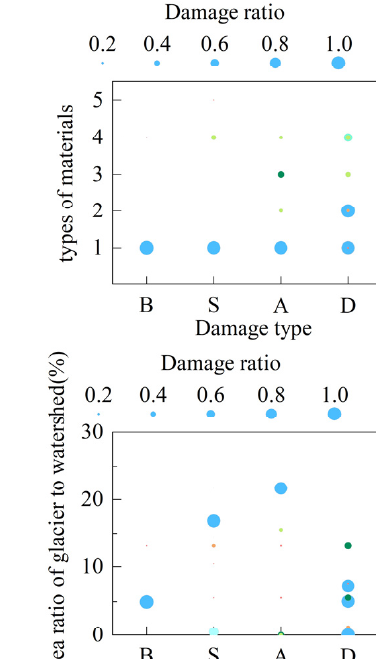
Figure 7. The relationship between debris flow formation conditions and damage type. B: brim-over damage, S: scour damage, A: abrasion damage, D: sedimentary damage The results show that the channel gradient has a positive correlation with the damage grade and has the biggest impact on sedimentary damage. When the soil sources of debris